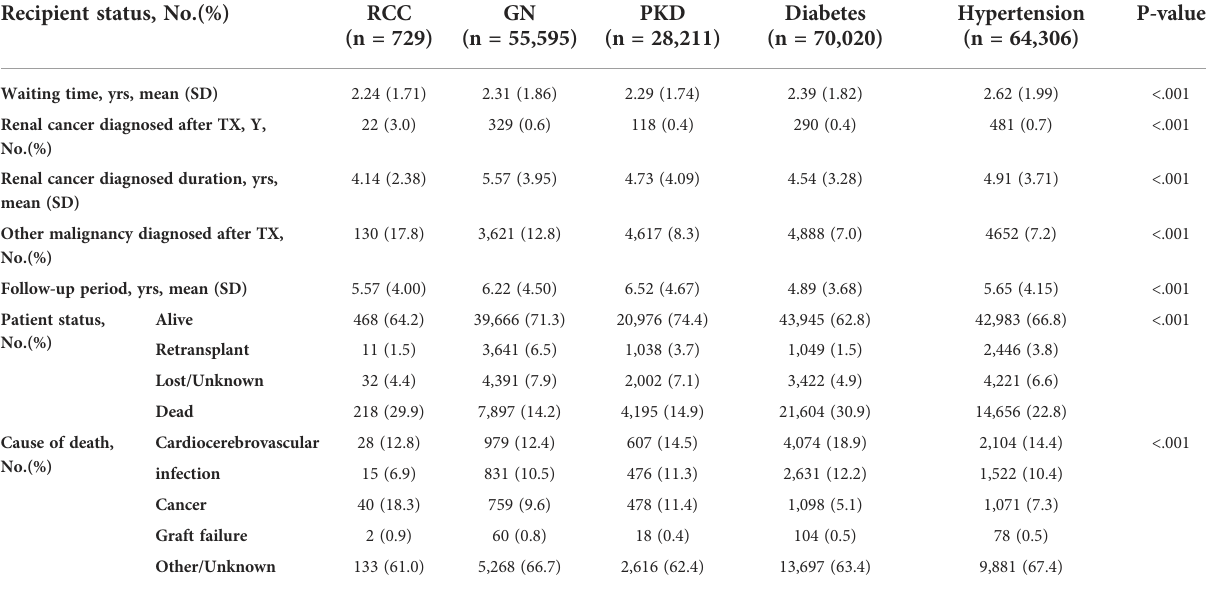
TABLE 4 Recipient status at most follow-up with cause of death. Recipient status,